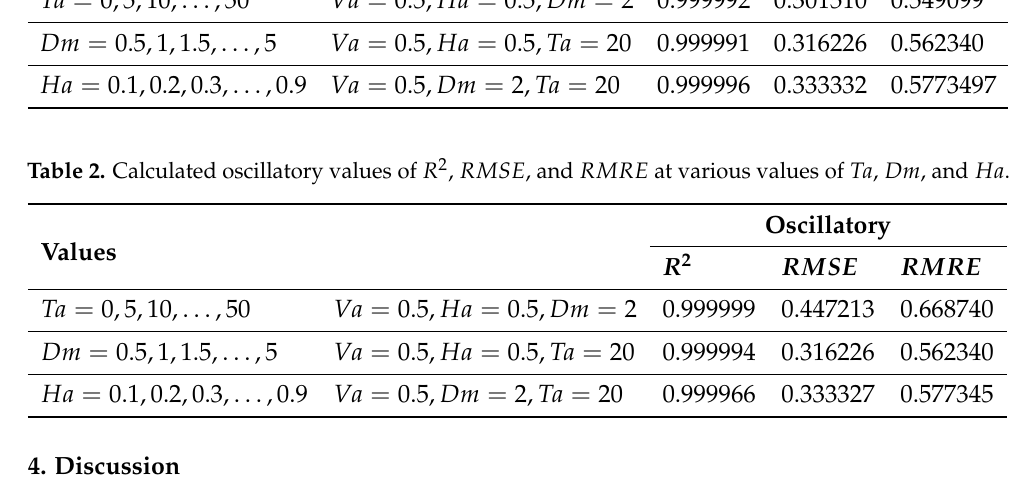
Table 1. Calculated stationary values of R 2 , RMSE , and RMRE at various values of Ta , Dm , and Ha . Stationary Values R 2 RMSE RMRE Ta = 0, 5, 10, . . . , 50 Va = 0.5, Ha = 0.5, Dm = 2 0.999992 0.301510 0.549099 Dm = 0.5, 1, 1.5, . . . , 5 Va = 0.5, Ha = 0.5, Ta = 20 0.999991 0.316226 0.562340 Ha = 0.1, 0.2, 0.3, . . . , 0.9 Va = 0.5, Dm = 2, Ta = 20 0.999996 0.333332 0.5773497